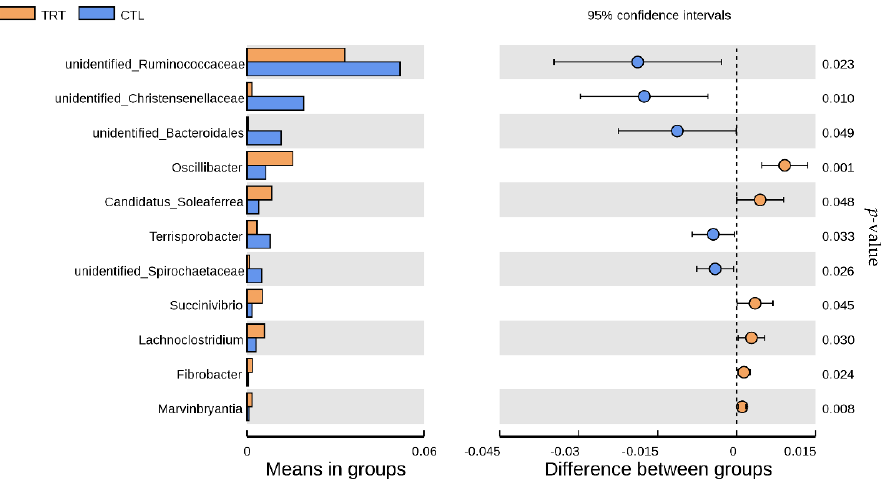
Figure 6. Analysis of distinct species between treatment groups at the genus level. n = 10. CTL, sow fed the basal diet; TRT, sow fed basal diet with silymarin 40 g/d from late gestation to lactation.